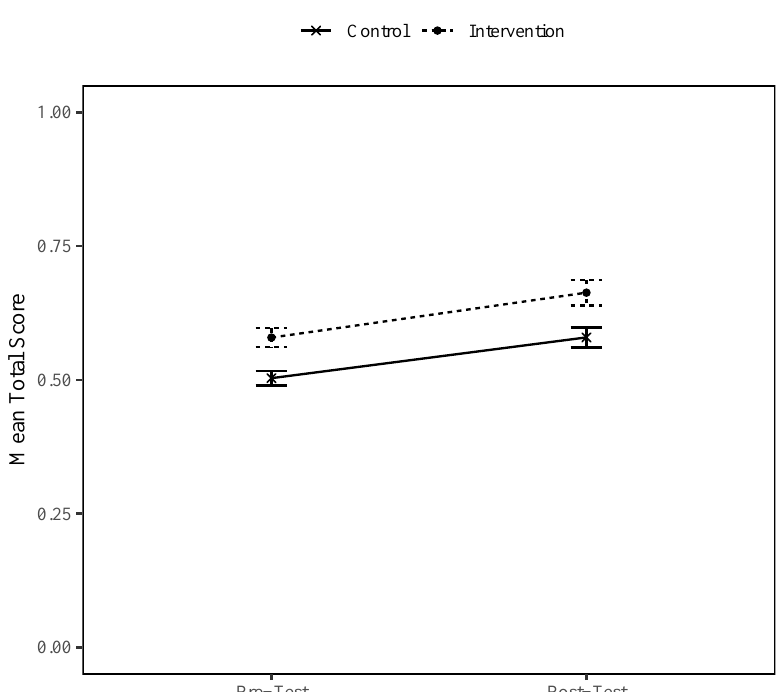
Figure 3. Mean total score of all items in the pre- and post-test for the intervention and control group (error bars represent standard error of the